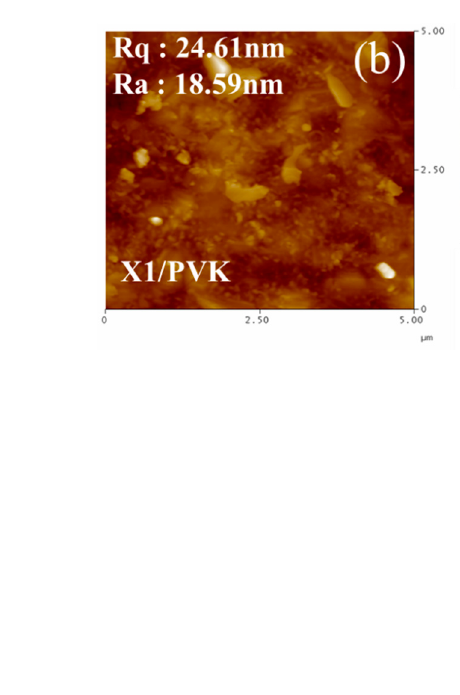
Figure 6. SEM images of ( a ) spiro-OMeTAD; ( b ) X1 ; and ( c ) X2 on perovskite film.